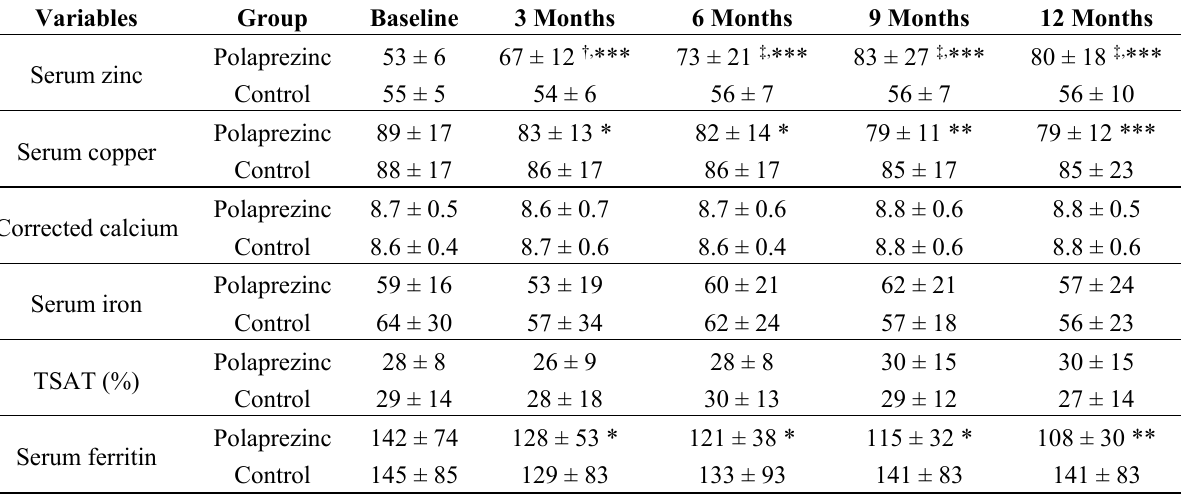
Table 2. Changes in various parameters during the study period.